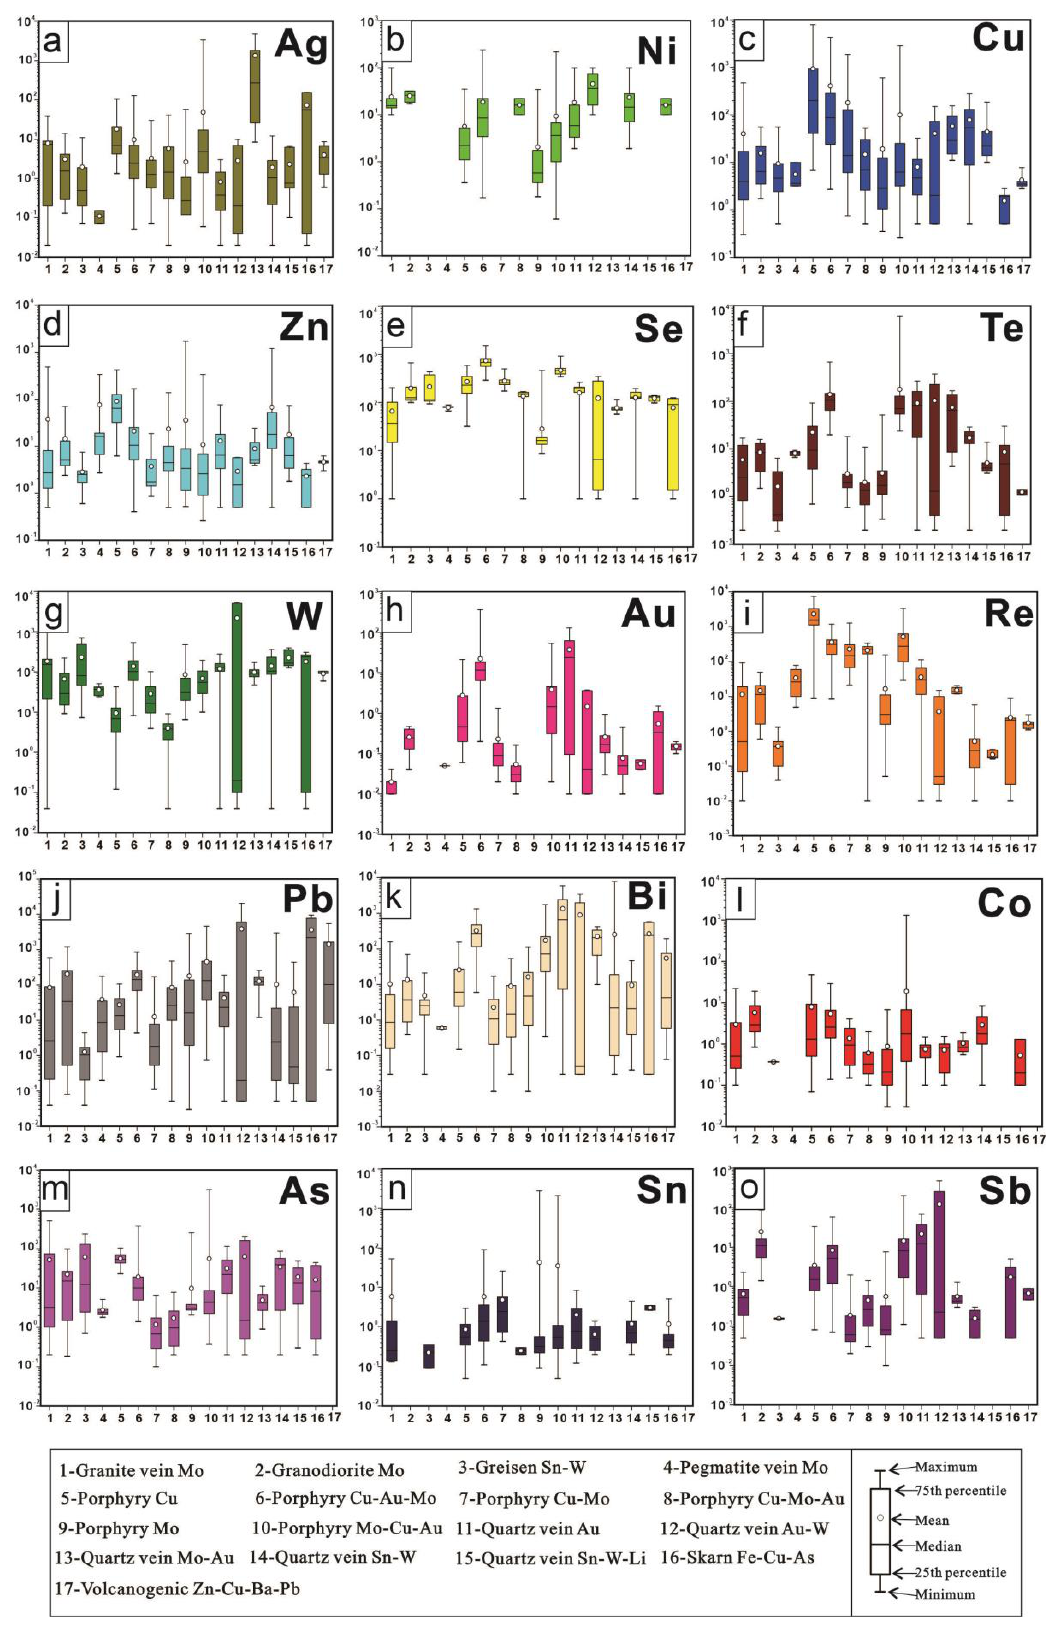
Figure 2. Multi-element box and whisker plots for LA–ICP–MS trace element data (ppm) of molyb- denite from seventeen deposit types. See detailed explanation in